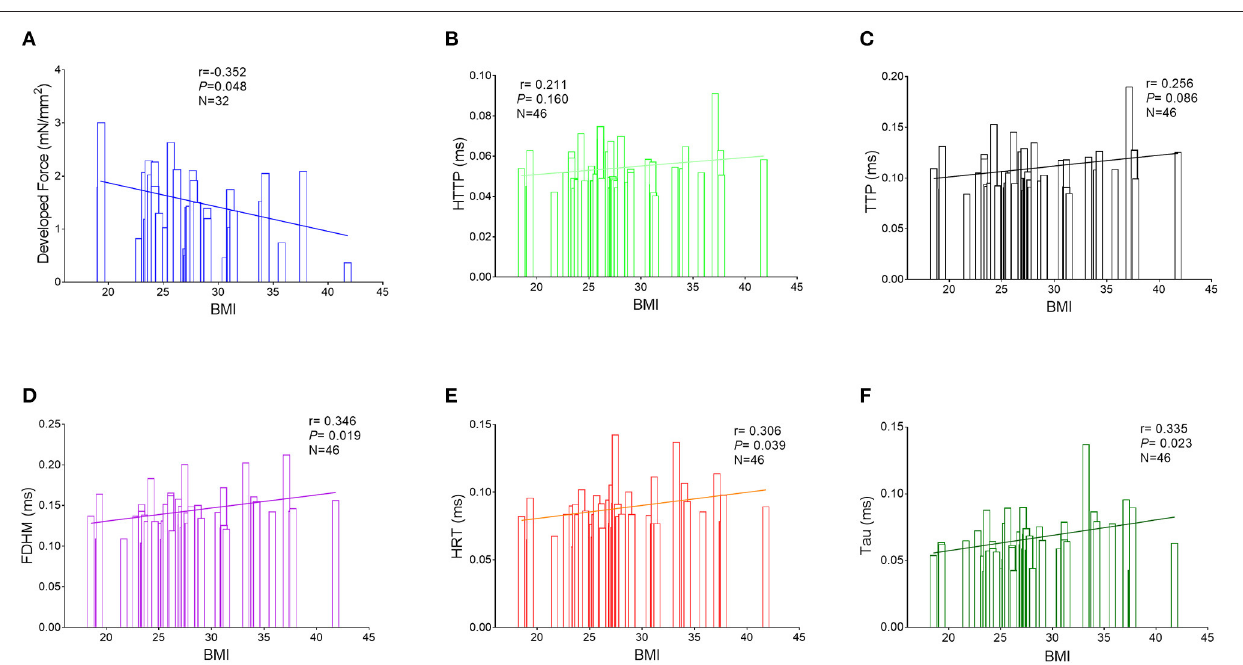
FIGURE 1 | Correlations between the BMI and measurements of the right atrial trabeculae function by the Pearson correlation analysis. (A) Correlations between the BMI and normalized developed force ( n = 32). (B) Correlations between BMI and HTTP ( n = 46). (C) Correlations between BMI and TTP ( n = 46). (D) Correlations between BMI and FDHM ( n = 46). (E) Correlations between BMI and HRT ( n = 46). (F) Correlations between BMI and Tau ( n = 46). BMI, body mass index; HTTP, half time to peak; TTP, time to peak; FDHM, full duration at half maximum; HRT, half relaxation time; Tau, relaxation constant.